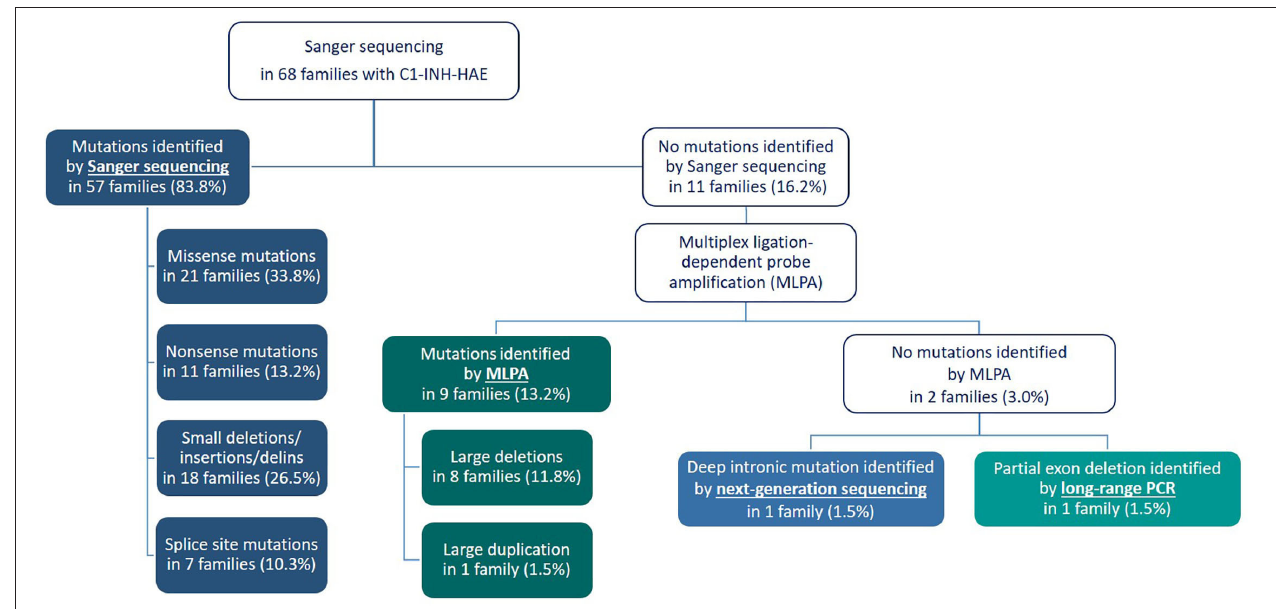
FIGURE 1 | Flow chart illustrating the algorithm for molecular genetic testing in the Hungarian Angioedema Center of Reference and